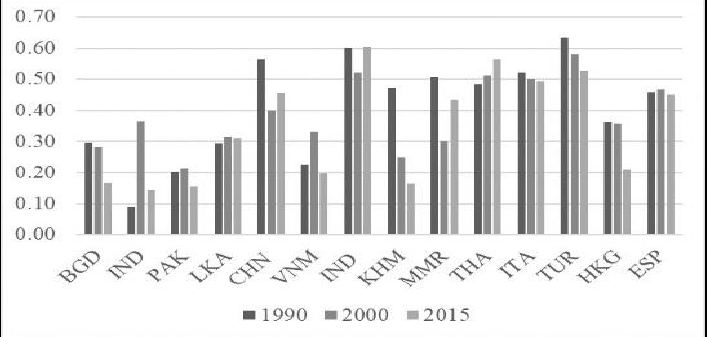
Figure 2: Value-added export (VAX) ratio from textile industry; Source: Authors